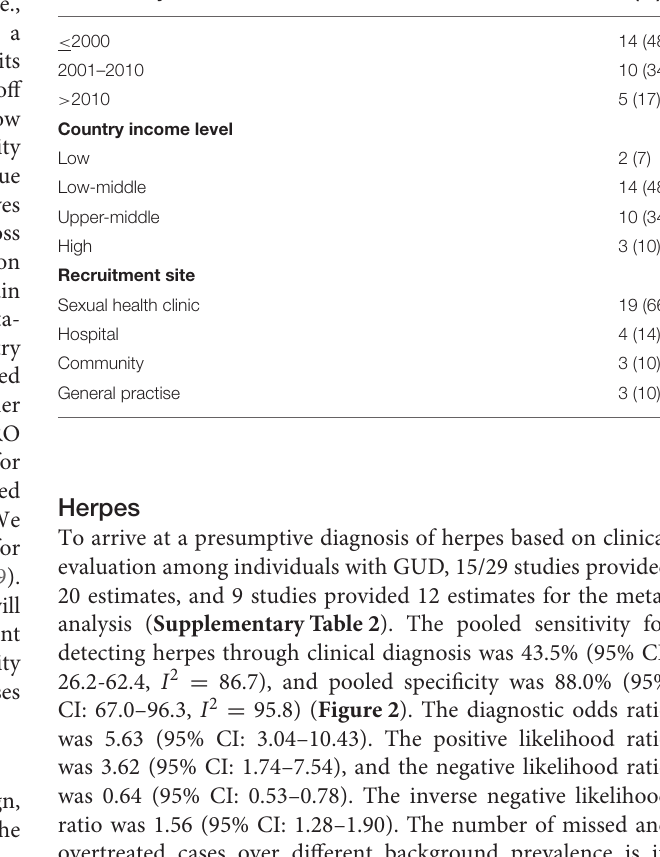
Supplementary Table 3 . The summary receiver operating curve